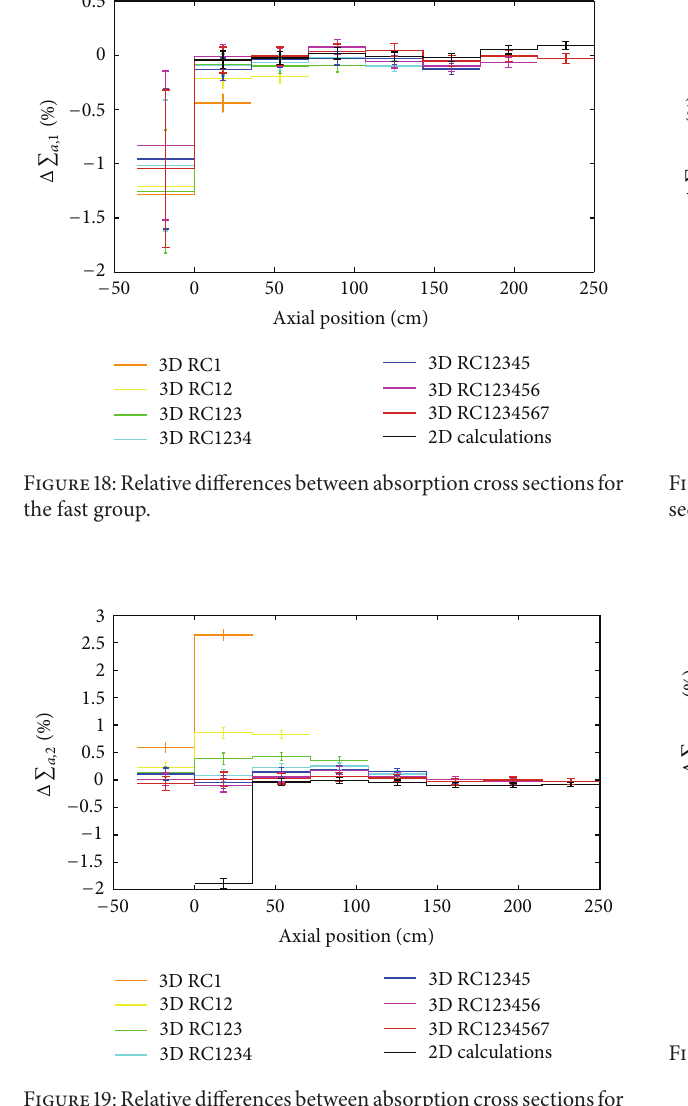
Figure19:Relativedifferencesbetweenabsorptioncrosssectionsfor the thermal group.